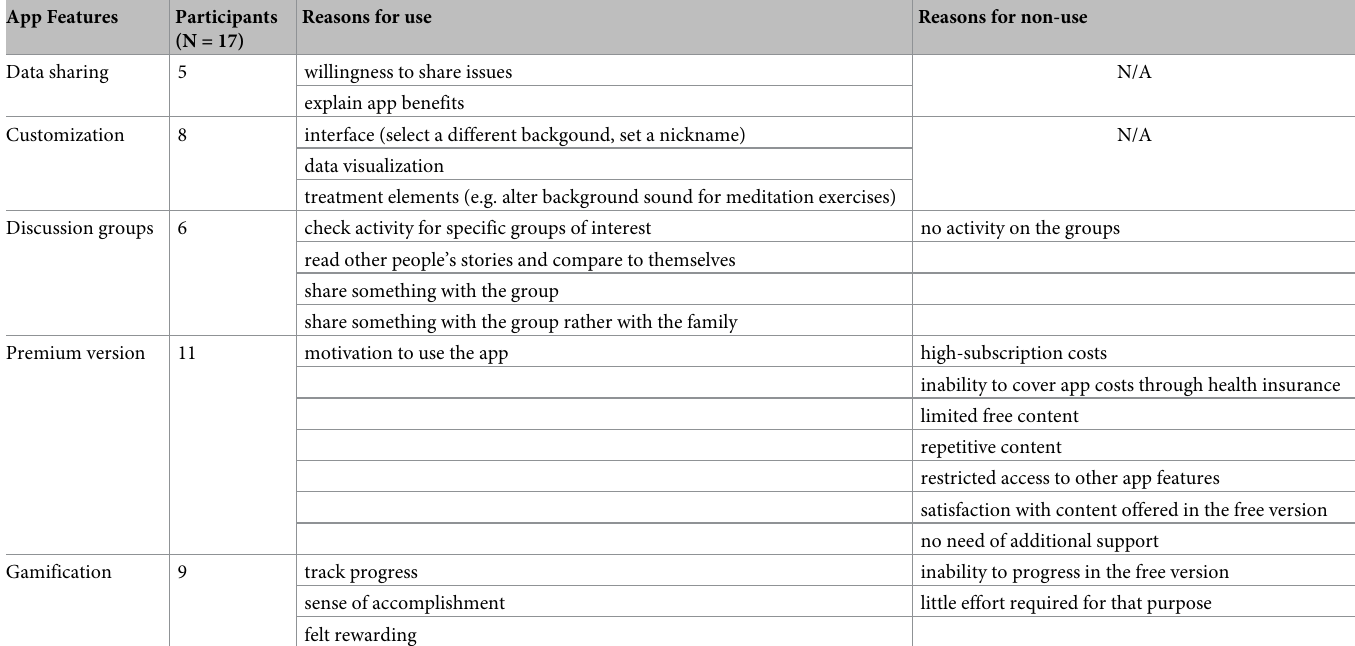
Table 3. Reasons for using app